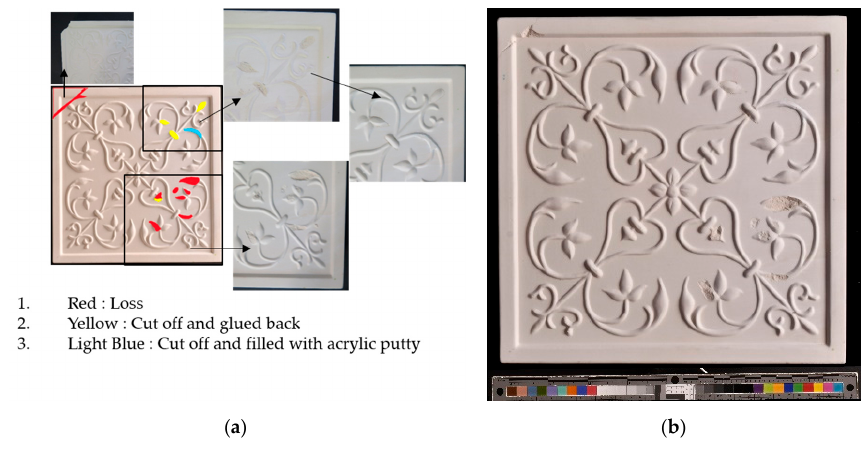
Figure 11. ( a ) Changes made to the tile; ( b ) the changed tile.